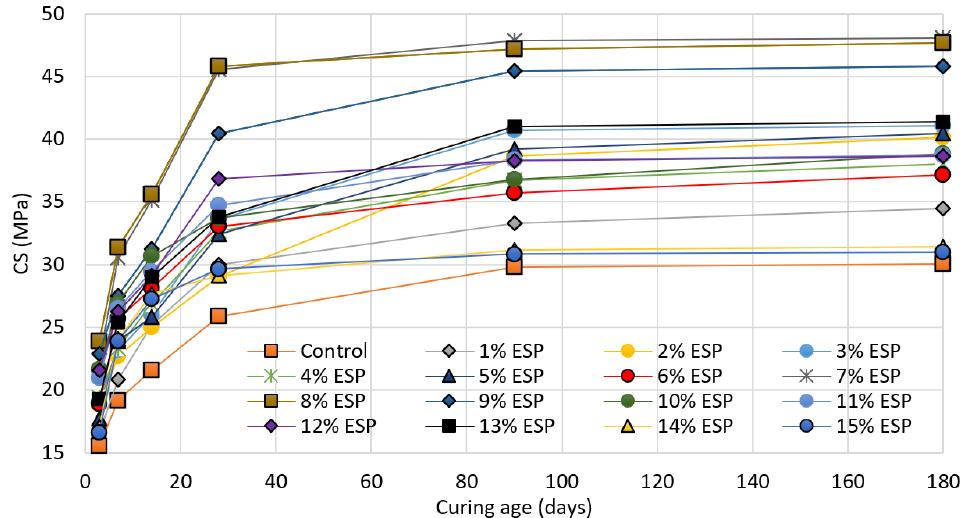
Figure 3. Compressive strength development in the studied mix designs.